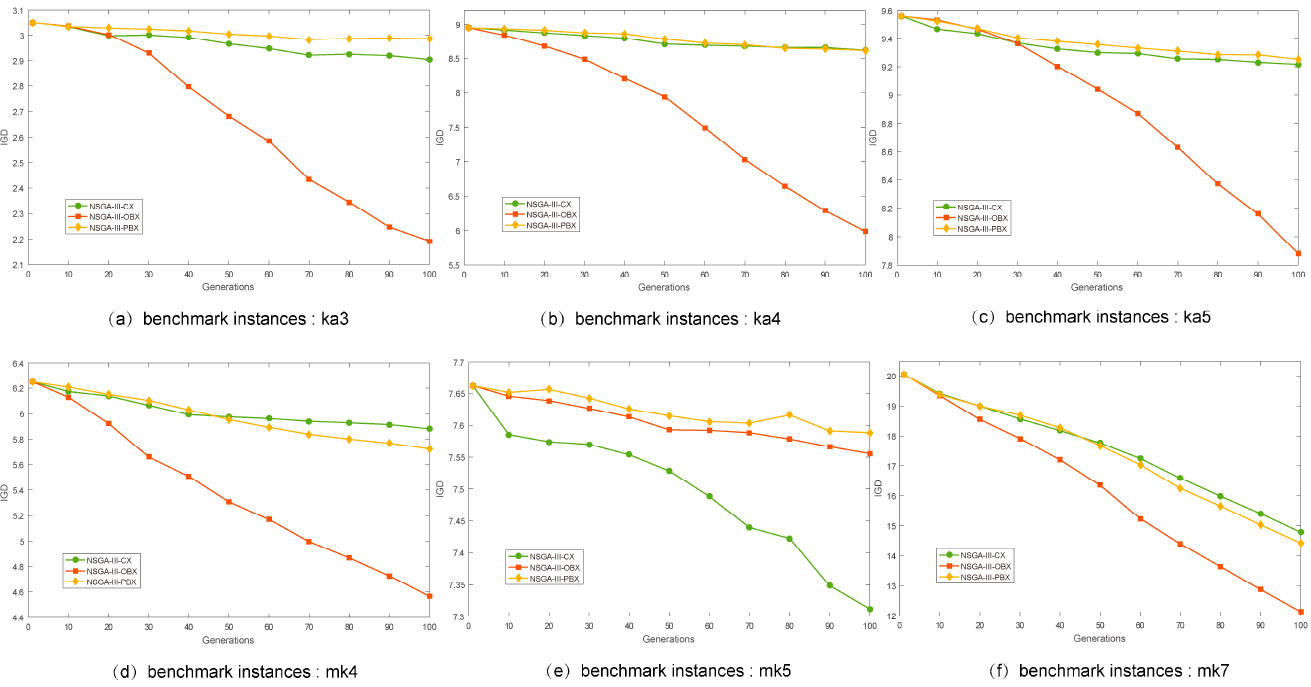
Figure 5. At population size of 300, the evolutionary trajectory of the IGD for the NSGA-III variants on the six FJSP instances (the average of the results of 30 independent runs; the initial population is the population close to the Pareto front in the target space).